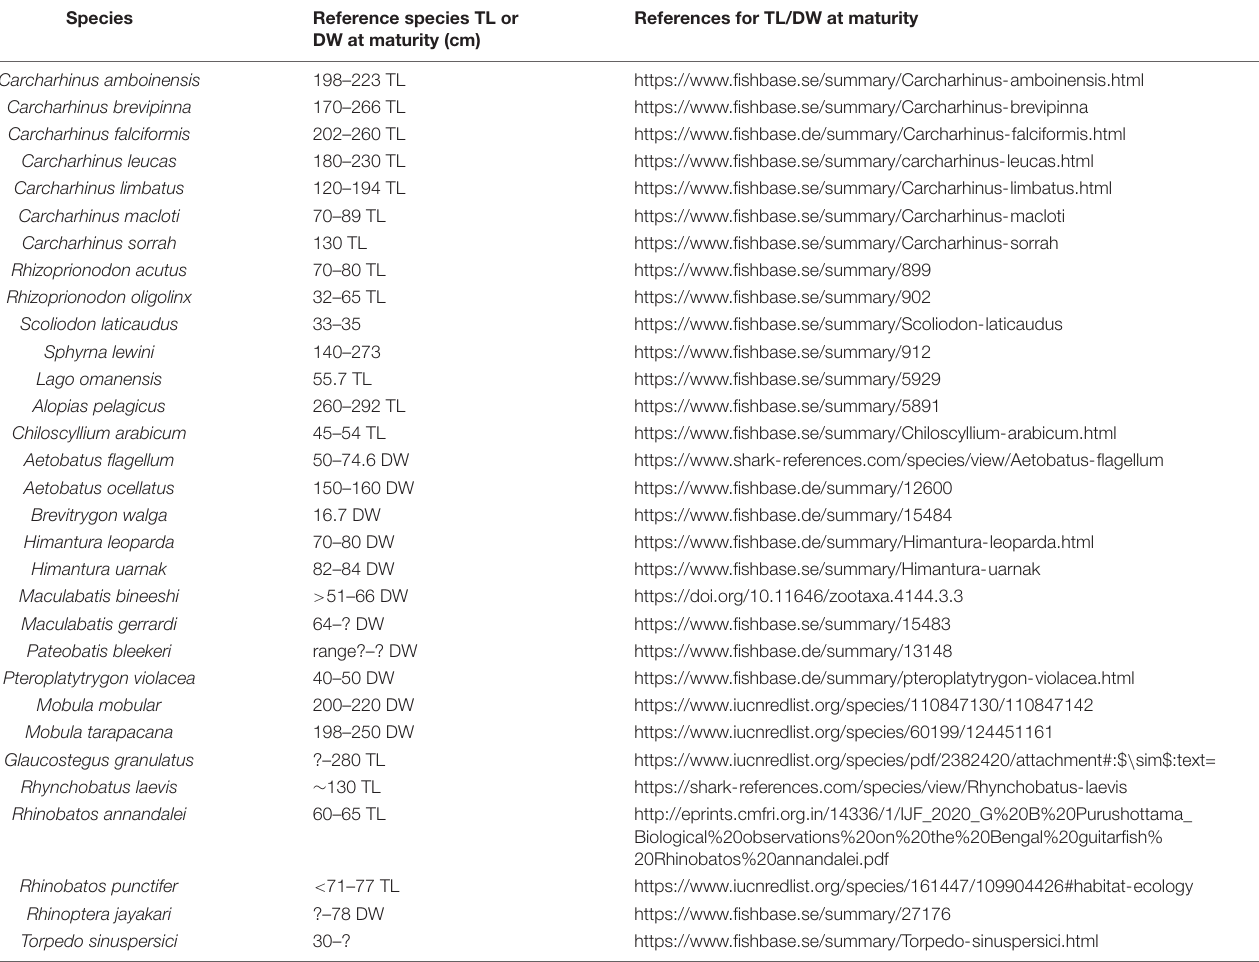
TABLE 1 | Total Length (TL) or Disc Width (DW) (cm) threshold used to determine maturity for each species are listed below.